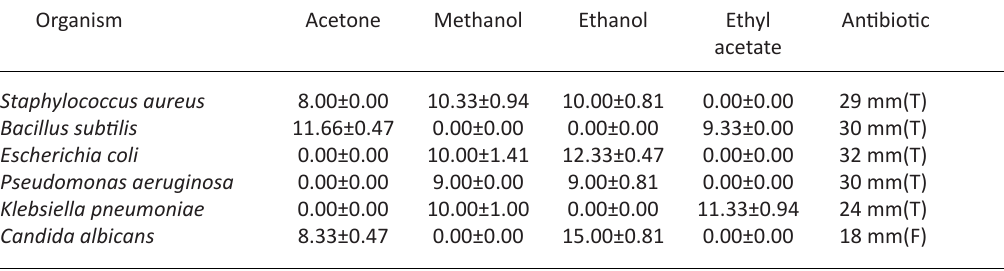
Table 2. Antibacterial activity of fruit peel and zones of inhibition (mm) Organism Acetone Methanol